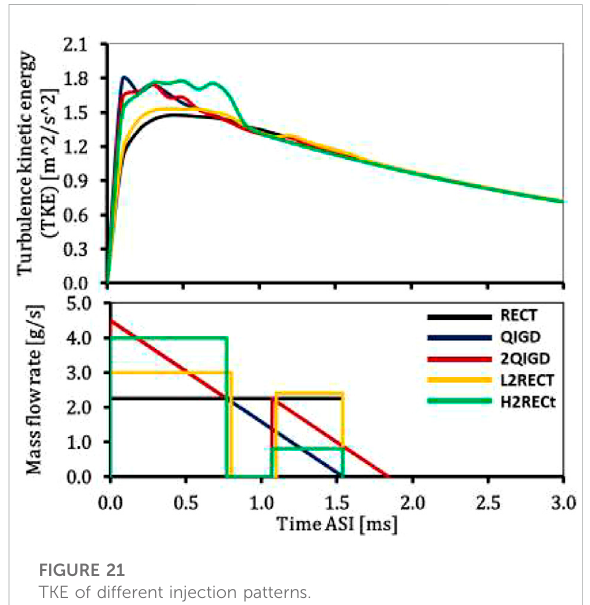
FIGURE 21 TKE of different injection patterns.